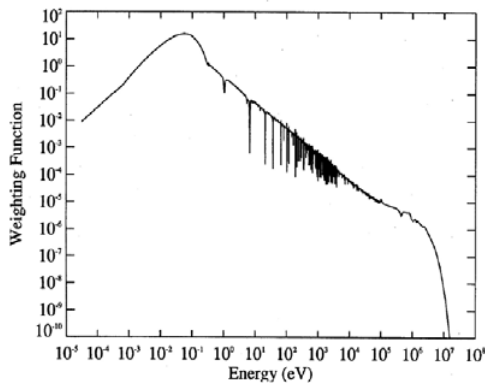
Figure 1 A typical neutron energy spectrum of a Light Water Reactor used as a weighting function in a generation of ORIGEN library